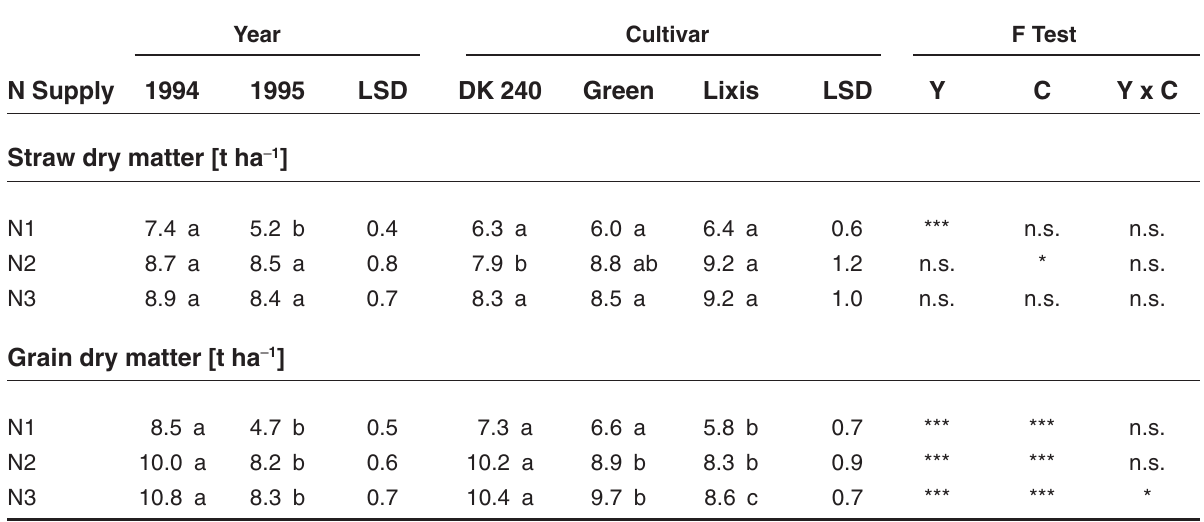
Straw and Grain Dry Matter of Maize as Influenced by Year (Y), Cultivar (C), and N Supply Year Cultivar F Test N